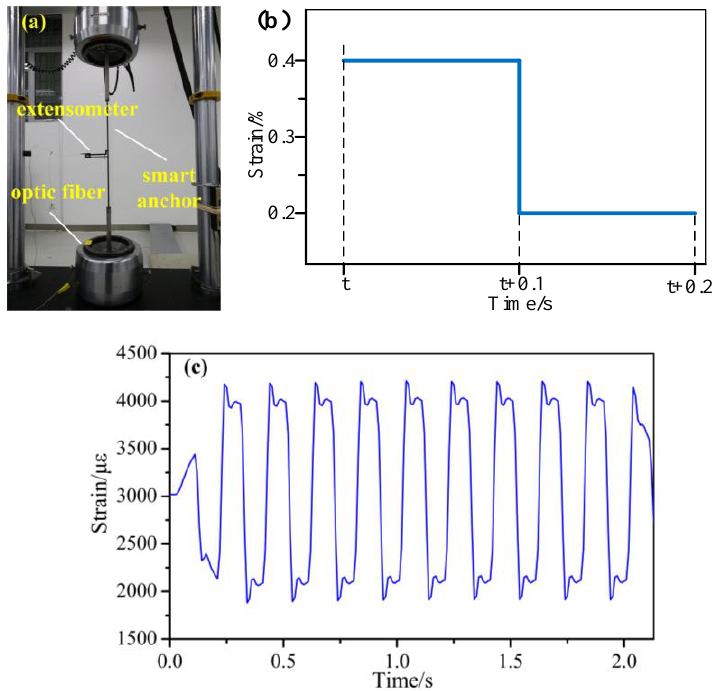
Figure 13. Measurement of the dynamic strain on the anchor: ( a ) the test setup; ( b ) the load with a square waveform applied to the anchor; ( c ) the measurement results of the dynamic strain on the anchor.